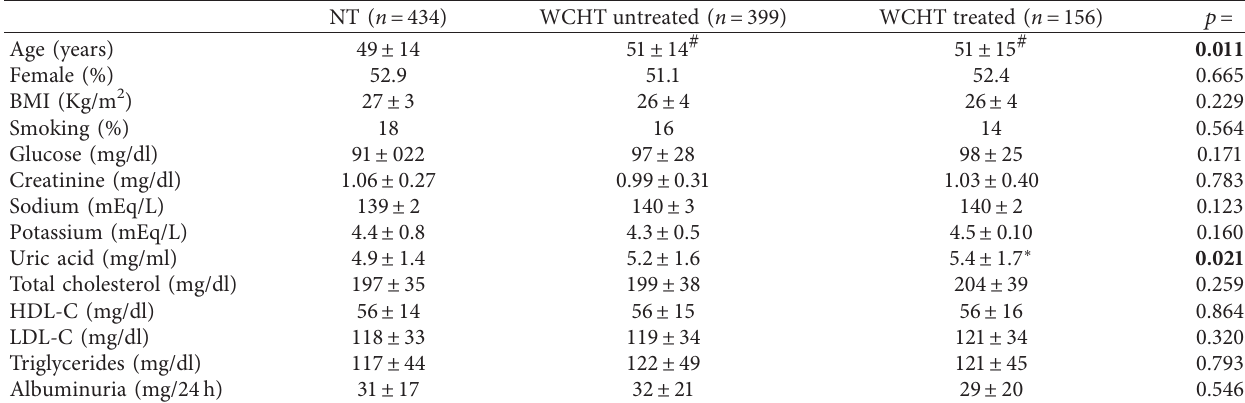
Table 1: Anthropometric biochemical data at